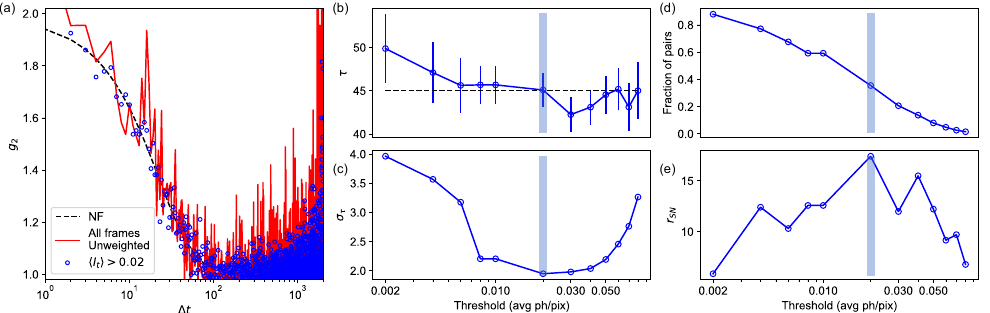
Figure 4. ( a ) The histograms of the TT ( t 1 , t 2 = t 1 + 1 ) for the “noise free” (NF, black line) and the simulated (SIM, red line) X-ray free electron laser (XFEL) datasets using the exponential distribution in Figure 3c,d. The dashed vertical line marks the value of the g 2, NF ( ∆ t = 1 ) . ( b ) Histograms of TT ( t 1 , t 2 = t 1 + 1 ) from a pair of strong speckle patterns (both with (cid:104) I t (cid:105) > 0.15 photons/pixel, green line), between a strong and a weak speckle pattern (one with (cid:104) I t (cid:105) > 0.15, and the other with (cid:104) I t (cid:105) < 0.05, magenta line), and a pair of weak patterns (both with (cid:104) I t (cid:105) < 0.05, blue shaded region).